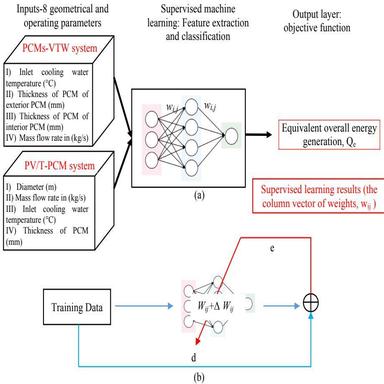
A holistic overview of the methodology in this study for the generation of the optimization function. The supervised machine learning was developed in the MATLAB environment. (a) The supervised machine learning model was selected and further trained to mimic the behaviour of the original 'teacher'; (b) The training process.